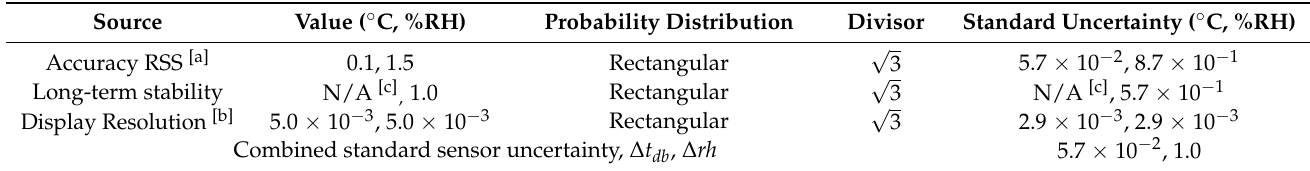
Table 7. Uncertainty budget for temperature and relative humidity sensor used to calculate humidity ratio.